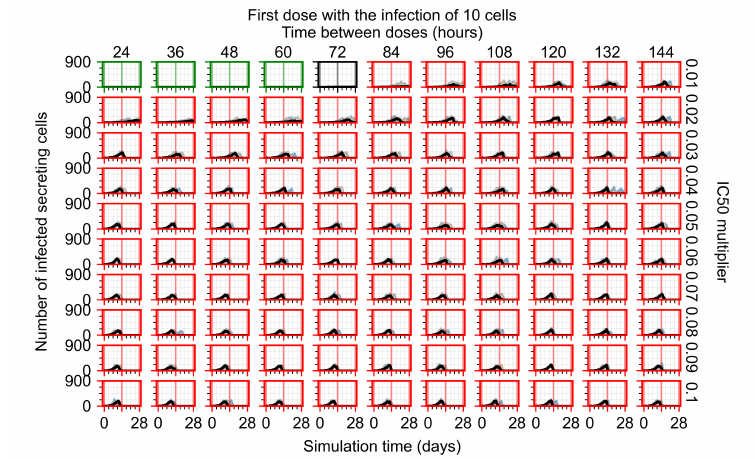
Figure A68. Infected (secreting extracellular virus) population.